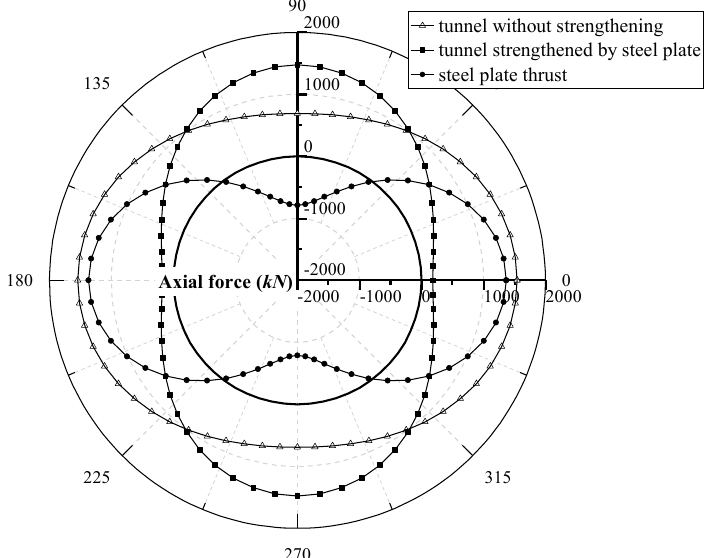
Figure 12. Axial force in the lining of tunnels with and without steel plate strengthening.